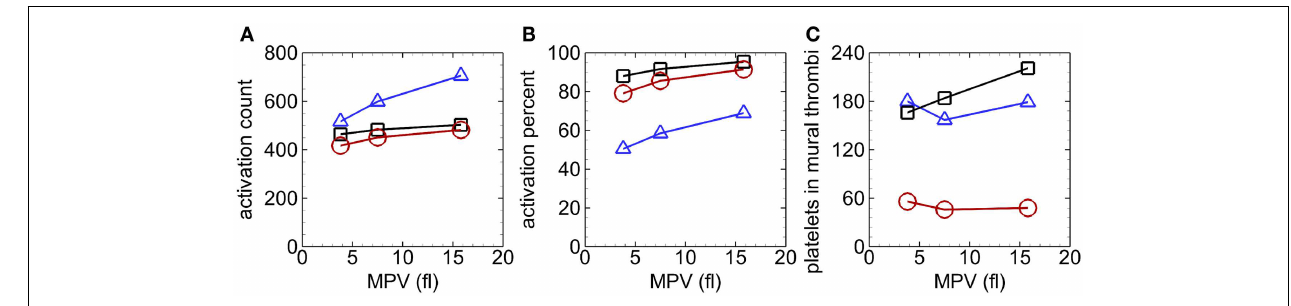
FIGURE 9 |Activation count versus MPV (A), activation percent versus MPV (B), and number of platelets in mural thrombi versus MPV (C), with whole-lumen-seeded platelets ( triangles ), near-wall-seeded platelets ( squares ), and RBCs with platelets ( circles ), in the high tortuosity arteriole at t = 1.54s for Cases 4–12